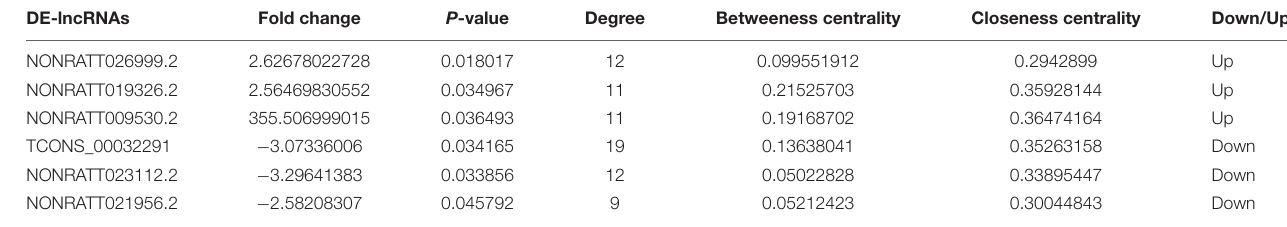
TABLE 5 | Basic information of the candidate 6 DElncRNAs.